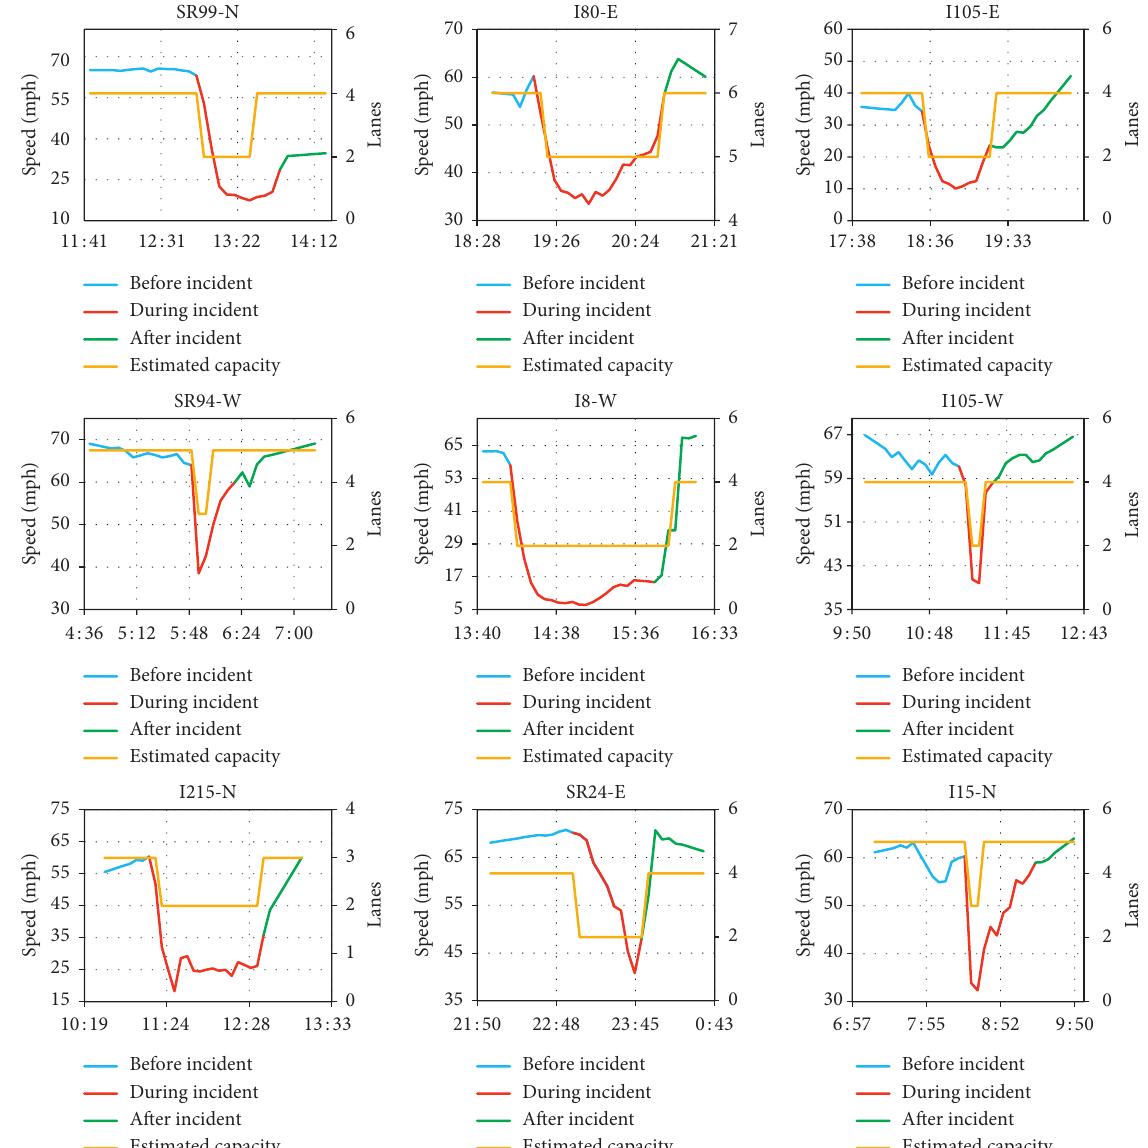
Figure 6: Comparison of estimated capacities with the speed profile. Table 6: Details of the estimated capacity during the incident as a function of available lanes.